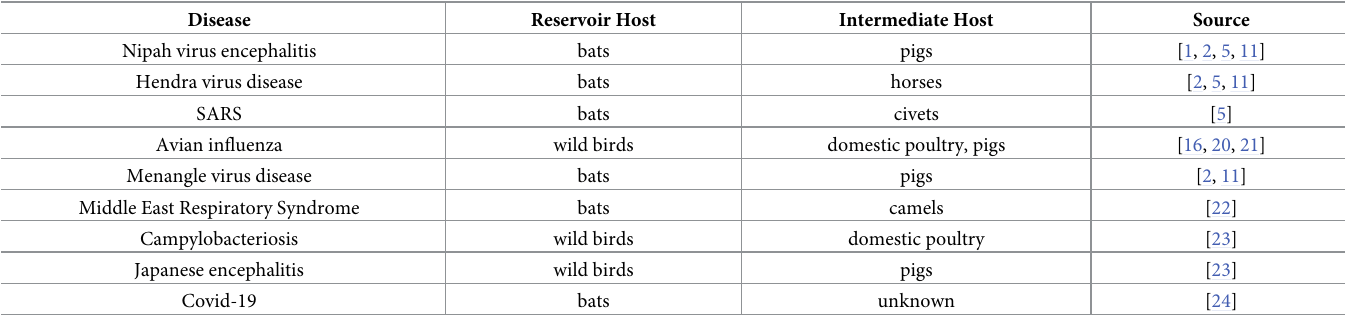
Table 1. Zoonotic diseases with intermediate hosts. Disease Hendra virus disease bats